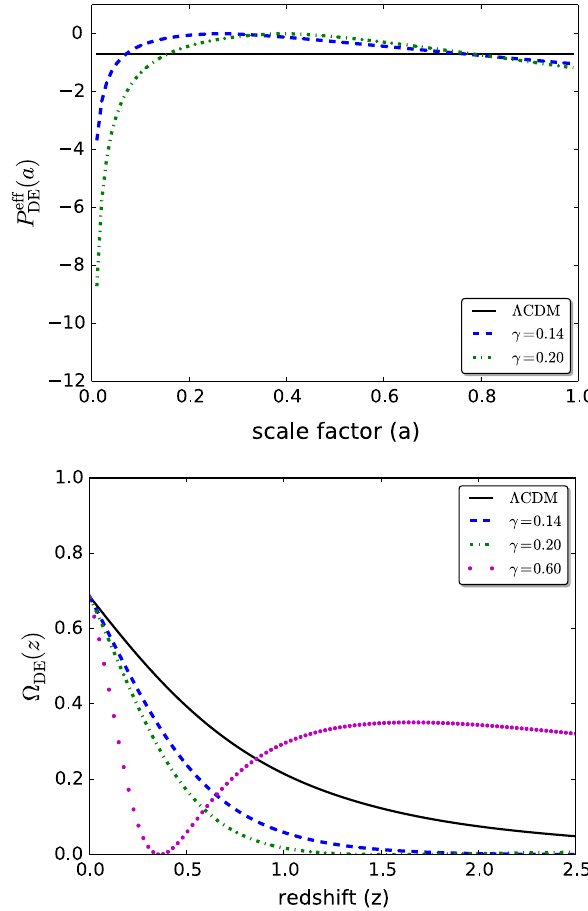
Fig. 1 Upper panel pressure of the viscous fluid as a function of scale factor. Lower panel Ω DE ( z ) as a function of the redshift. In both cases we changed the value of γ . The other free parameters have been fixed by SNIa constraint. The Λ CDM best fit is given by Planck observation